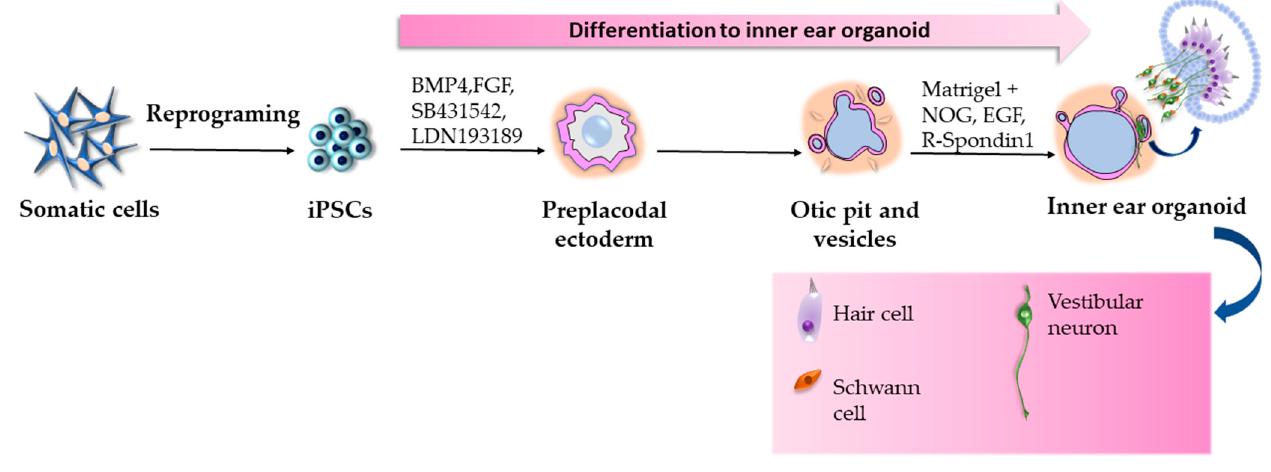
Figure 7. Generation of inner ear organoids according to the protocol by Koehler et al. [141].